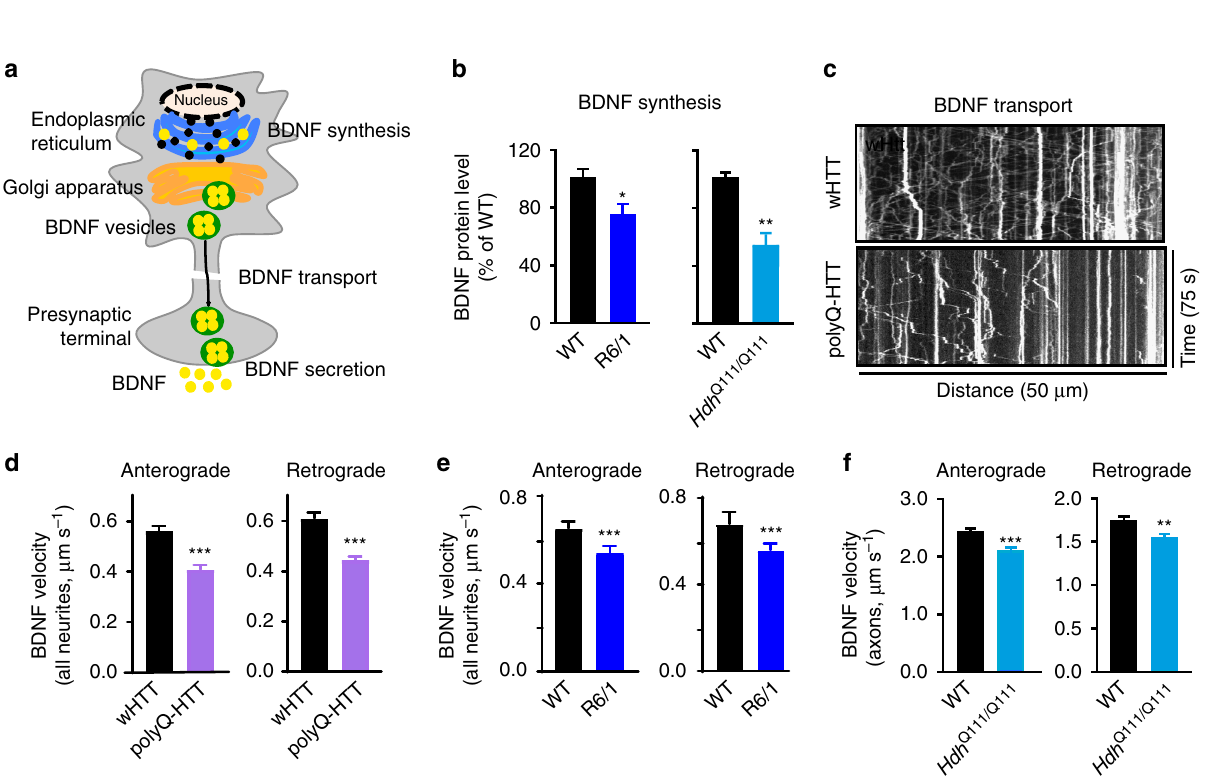
Fig. 2 BDNF synthesis and intracellular transport were impaired in various HD models. a Schematic diagram showing that BDNF is modulated at synthesis, transport, and secretion levels. b Hippocampal BDNF protein level determined by ELISA in R6/1 and Hdh Q111/Q111 mice; values are mean ± s.e.m (% of WT); n = 21 and 14 mice for WT and R6/1 ; n = 6 and 9 mice for WT and Hdh Q111/Q111 , respectively. c Representative kymographs of intracellular transport of BDNF-containing vesicles (white trajectories) in a neurite (50 μ m from soma) over 75 s in wHTT- and polyQ-HTT-expressing rat hippocampal neurons. The velocity of BDNF transport was re fl ected by the slope of trajectories (moving distance against time). d – f Anterograde and retrograde BDNF transport velocity in all neurites of wHTT- and polyQ-HTT-expressing rat hippocampal neurons ( d ) and hippocampal neurons from R6/1 mouse line ( e ) and in the axon of hippocampal neurons from Hdh Q111/Q111 mouse line ( f ); values are median ± 95% c.i. ( d , e ) or mean ± s.e.m ( f ); n = 5569, 5656, 5227, and 5706 trajectories for anterograde and retrograde wHTT and polyQ-HTT, respectively; n = 1424, 1710, 1376, and 1487 trajectories for anterograde and retrograde WT and R6/1 , respectively; n = 236, 261, 194, and 256 trajectories for anterograde and retrograde WT and Hdh Q111/Q111 , respectively. Signi fi cance was determined by unpaired two-tailed Student ’ s t test ( b , f ) or two-tailed Mann – Whitney test ( d , e ); * P < 0.05, ** P < 0.01, *** P < 0.001 littermate controls (Fig. 2b). We next studied BDNF intracellular Hdh Q111/Q111 mouse hippocampal neurons exhibited slower transport in 3 complementary HD cellular models, as data on the transport compared to respective WT littermate controls (Fig. 2e, BDNF intracellular transport in the hippocampus of HD mice are f, respectively). Note that we observed a slower BDNF velocity in still lacking. Neurons expressing polyQ-HTT exhibited slower neurites (Fig. 2d, e) as compared to axons in hippocampal neu- anterograde and retrograde BDNF intracellular transport relative rons (Fig. 2f), which is consistent with previous studies in cortical to wHTT-expressing neurons (Fig. 2c, d). Similarly, R6/1 and neurons 26,27 . Altogether, these data suggested that reduced BDNF